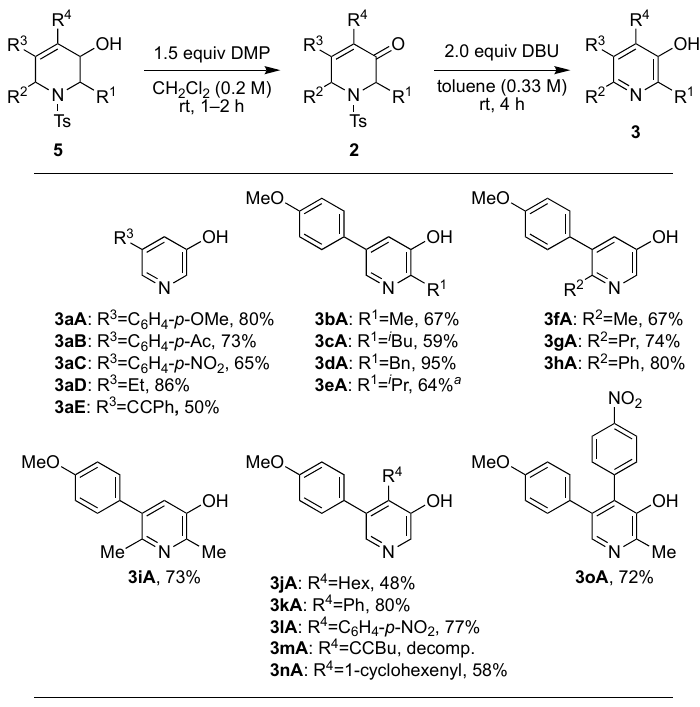
3 -catalyzed arylative cyclizations of internal